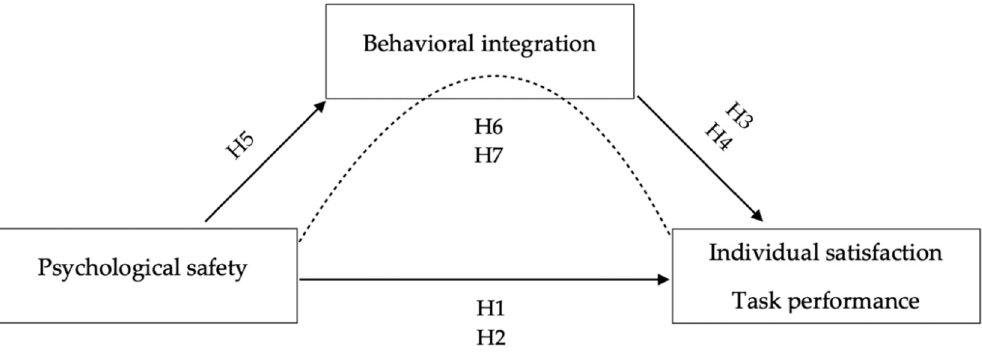
Figure 2. A conceptual model of our hypotheses and the relationship between the variables in this study. Table 5. Means, standard deviation and partial correlations for variables in H1, H2, H3, H4 and H5 controlled for team size and management team level. n =